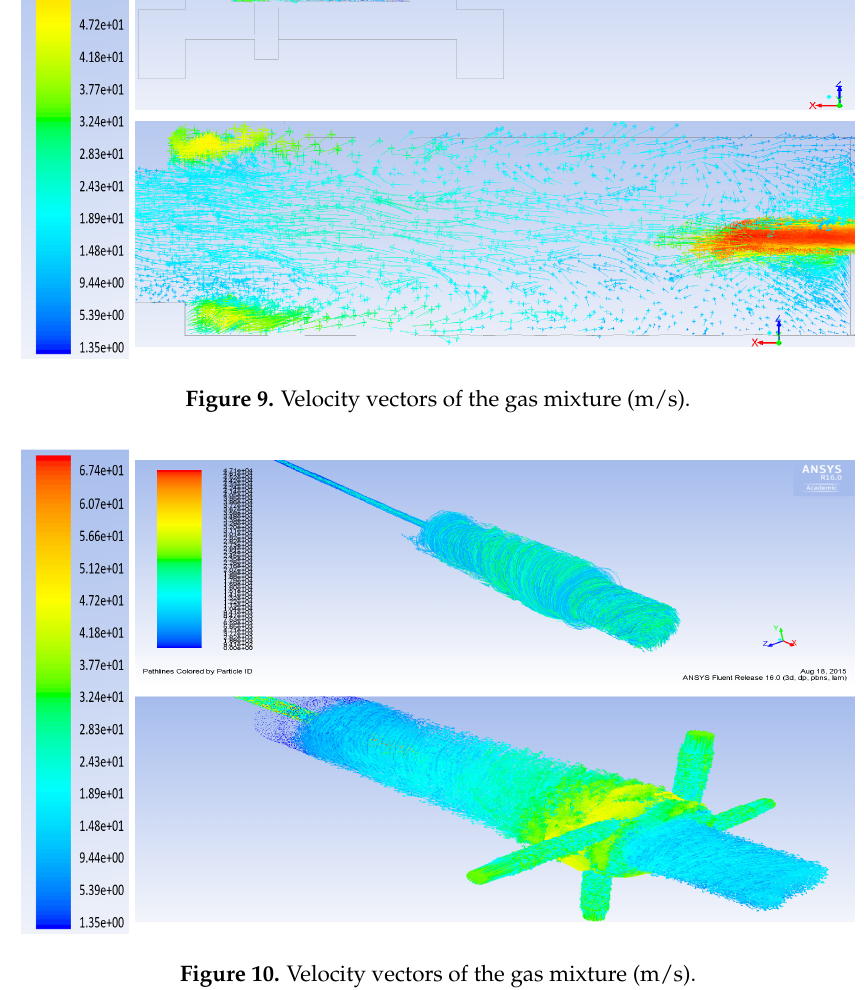
Figure 10. Velocity vectors of the gas mixture (m/s).